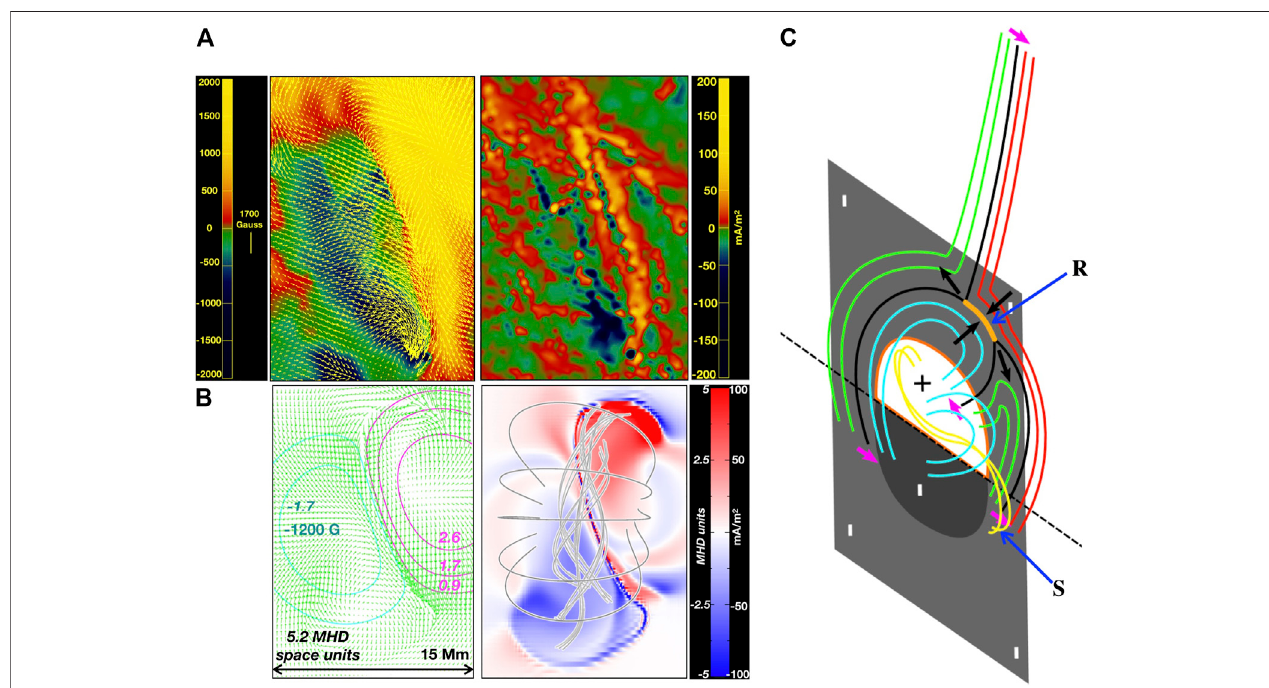
FIGURE 8 | Large fl ux rope detected in the HMI magnetic vector map computed with UNNOFIT code (Bommier, 2016) (A) Magnetic fi eld Bz overlaid by arrows of thehorizontalmagnetic fi eld(theyellow(dark)blueareasshowthepositive(negative)magnetic fi eldpolarity)andelectriccurrentdensitymapJz. (B) Comparisonwiththe OHMMHDsimulationofa fl uxrope.ThevectorpatternofobservationsandmodellooksthesameastheyarestronglynearlyparalleltothePILandconvergingtogetherin the bottom part to the site of reconnection S (from Joshi et al. (2020b)). (C) Schematic view of magnetic fi eld lines in the jet bald patch MHD simulation; in yellow is drawnthe fl uxrope withasigmoidshape[adaptedfromWyperet al.(2019)].ThereconnectionisatRinthestudyofWyperetal.(2019) but,areconnectionat Swillbea better fi t to the Joshi et al. (2020b) observations.